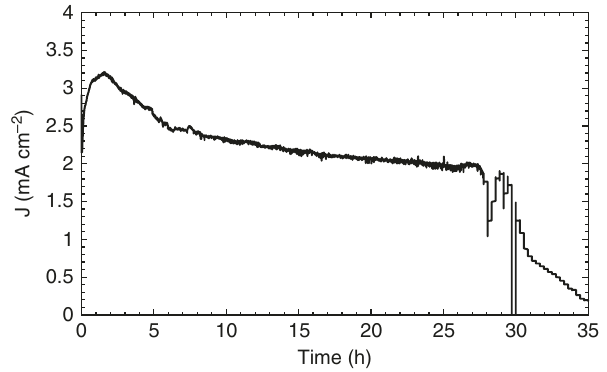
Fig. 4 Long-term stability of TiO 2 |CsPbBr 3 |m-c|GS70 in water. Chronoamperometric trace of TiO 2 |CsPbBr 3 |m-c|GS70 recorded at an applied potential of 1.23 V RHE . 0.1 M KNO 3 electrolyte solution pH 7, under continuous simulated solar light irradiation (AM 1.5 G, 100 mW cm − 2